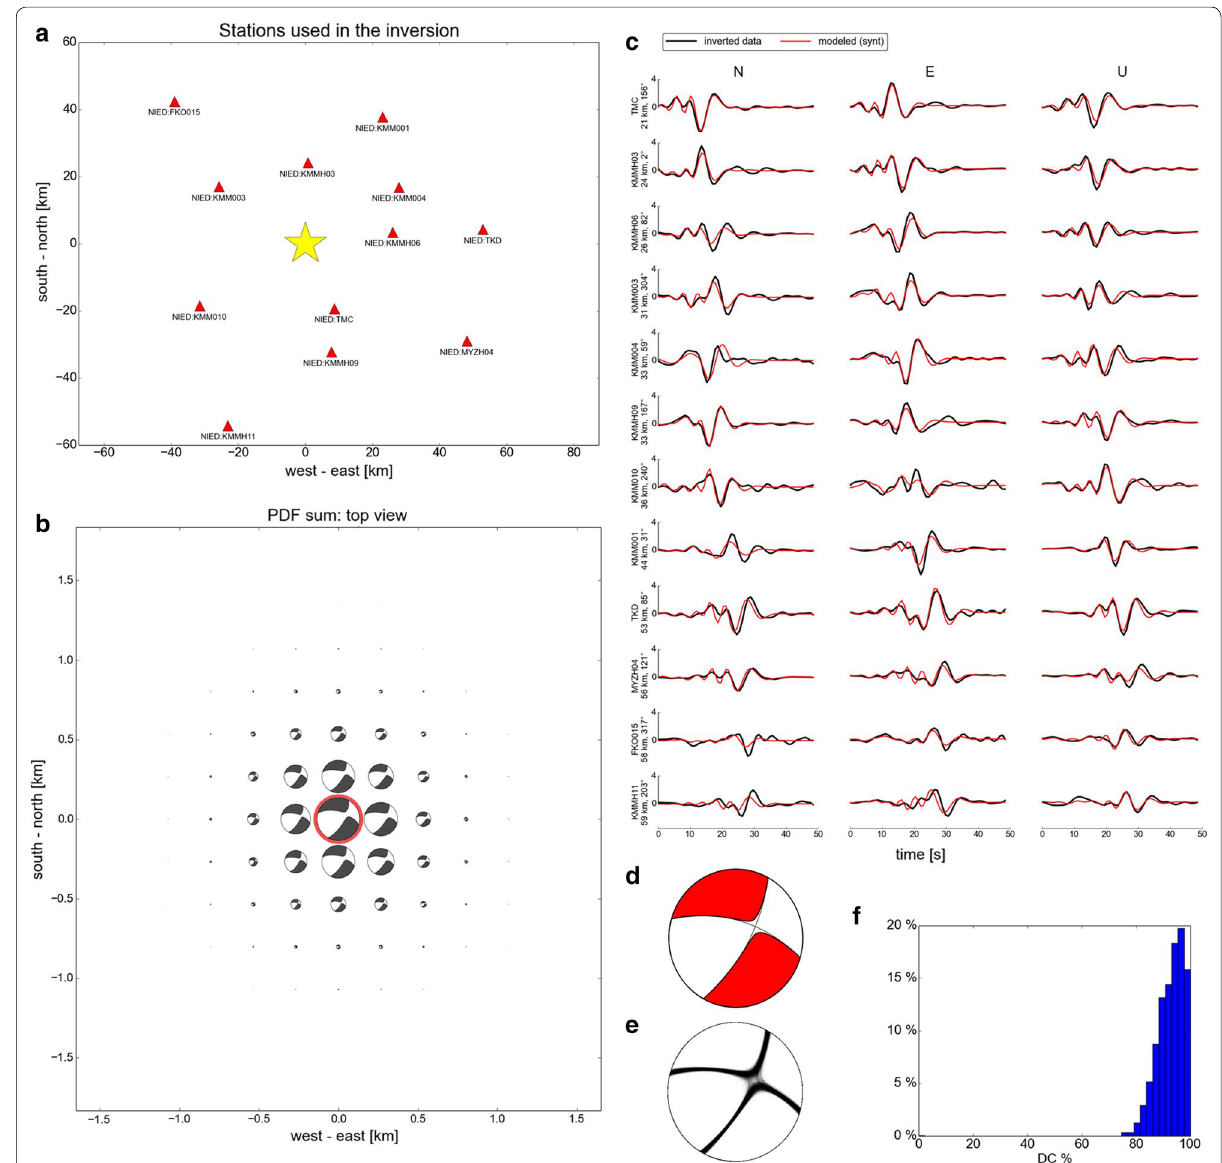
Fig. 4 Same as Fig. 3, but for the M JMA 5.8 foreshock from 2016/4/14 22:07:35 JST (event No. 4); a the map of strong motion stations (red triangles) used for the CMT inference; b marginal PDF of the CMT location in a horizontal slice indicated by the size of the beach-balls; the beach-balls depict inferred MTs at the individual spatial points. The beach-ball highlighted by red circle is the solution with the highest variance reduction (the best fitting solution); c the comparison between measured and synthetic standardized waveforms for the best fitting solution; d the beach-ball repre- sentation of the best fitting CMT; e the uncertainty of the mechanism depicted by 1000 random possible solutions drawn from the ten-dimensional posterior PDF; f histogram of the DC